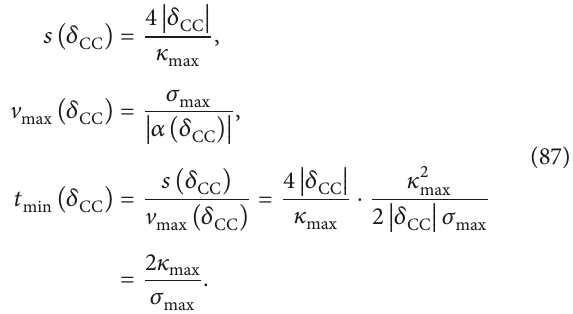
Algorithm 1: The basic RRT construction algorithm